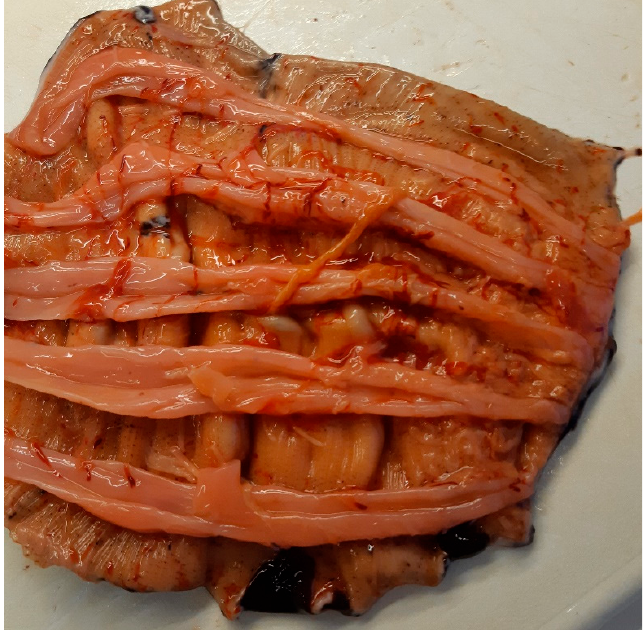
Figure 1. Gutted orange-footed sea cucumber ( Cucumaria frondosa ) (Photo: A. Langdal).